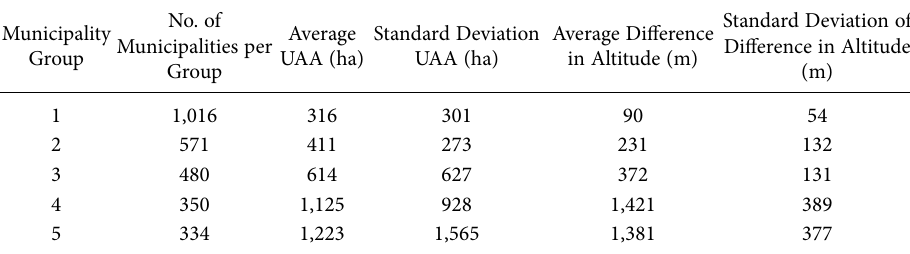
Table 1. Description of the municipality groups.